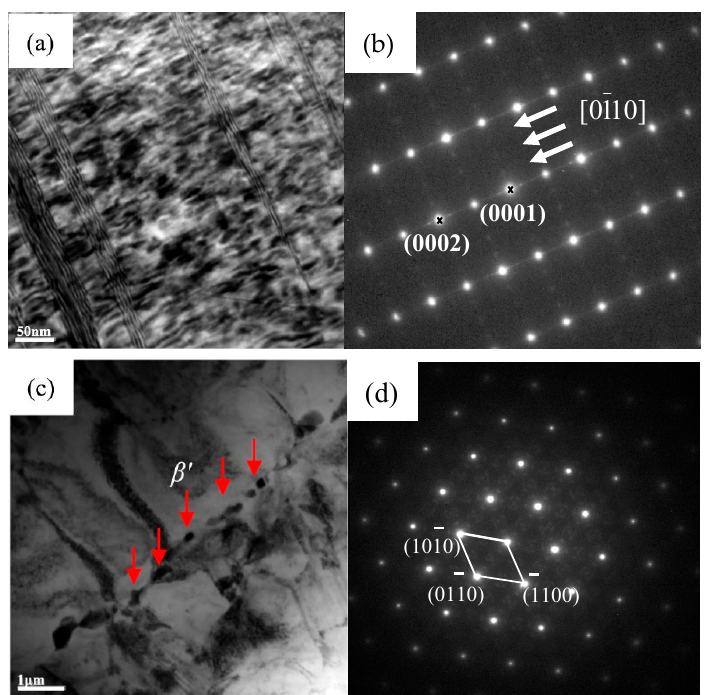
Figure 3. ( a ) Bright-field transmission electron microscope (TEM) image and corresponding selected area electron diffraction (SAED) pattern of β′ phase in the forged and extruded alloy; ( b ) TEM image and corresponding SAED pattern of β′ phase in the forged alloy, B // [2110]; ( c ) and ( d ) TEM image and corresponding SAED pattern of β′ phase in the extruded alloy, B//[0001].